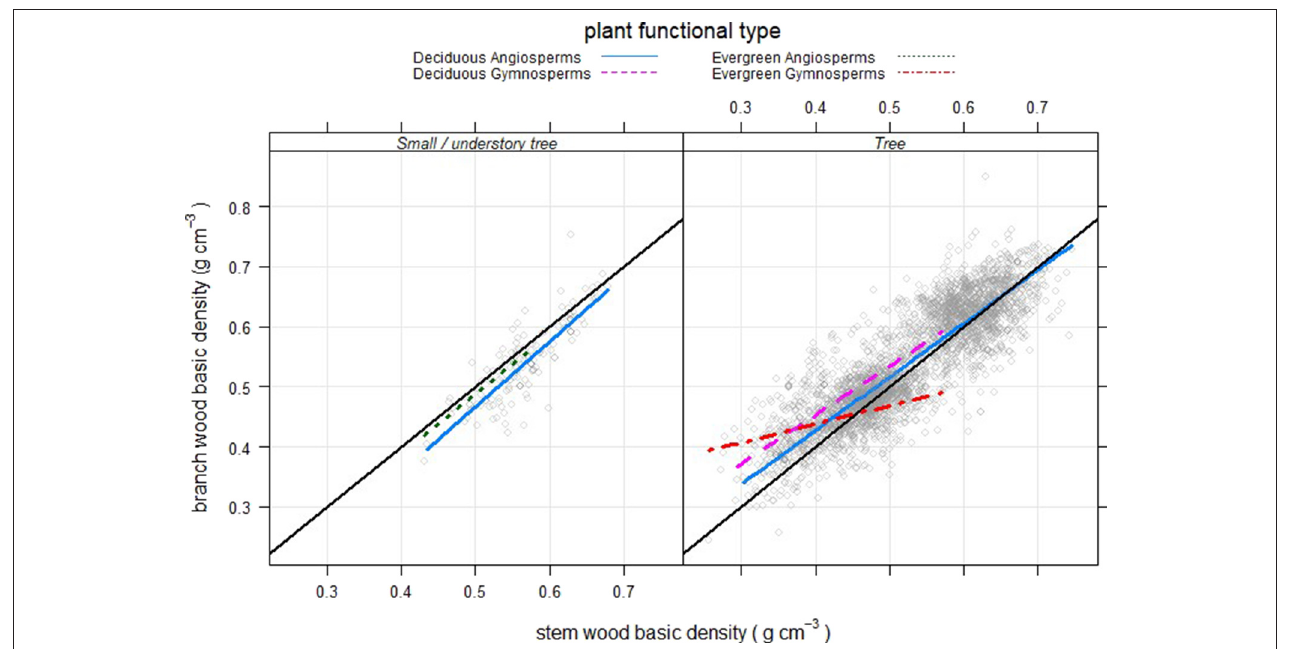
FIGURE 3 | Branch wood – stem wood basic density relationships for North American trees (gray circles) of for different functional types.